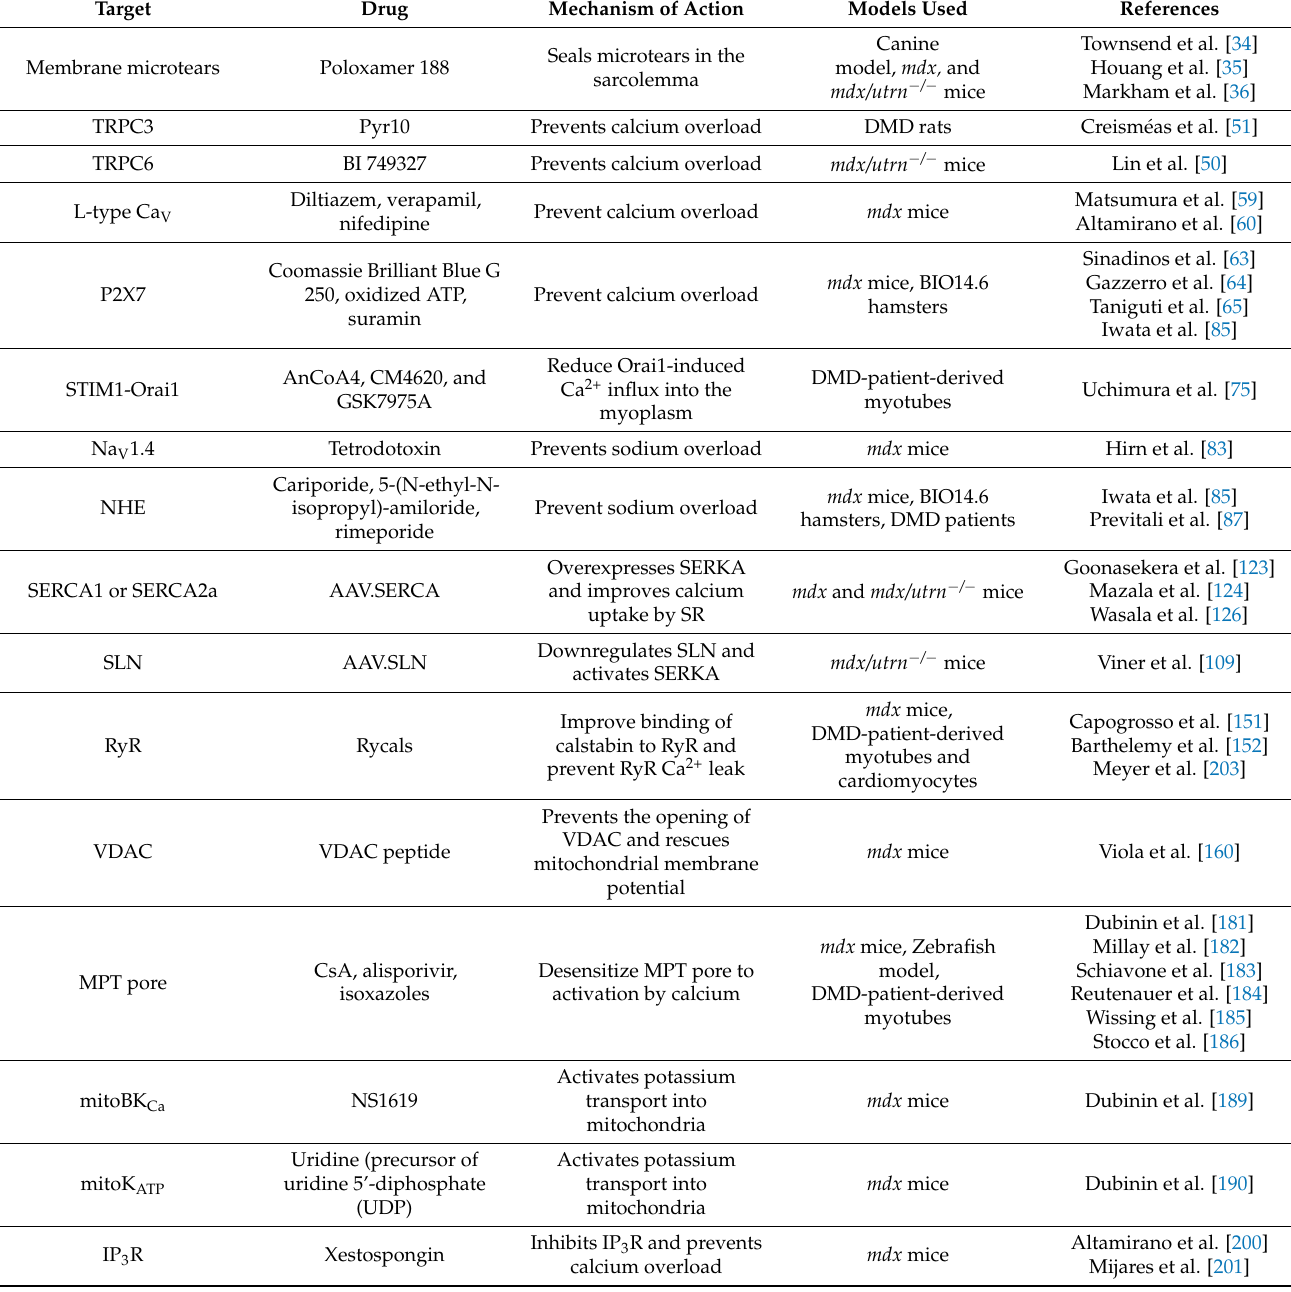
Table 1. Ion channels and membrane defects in DMD and their pharmacological